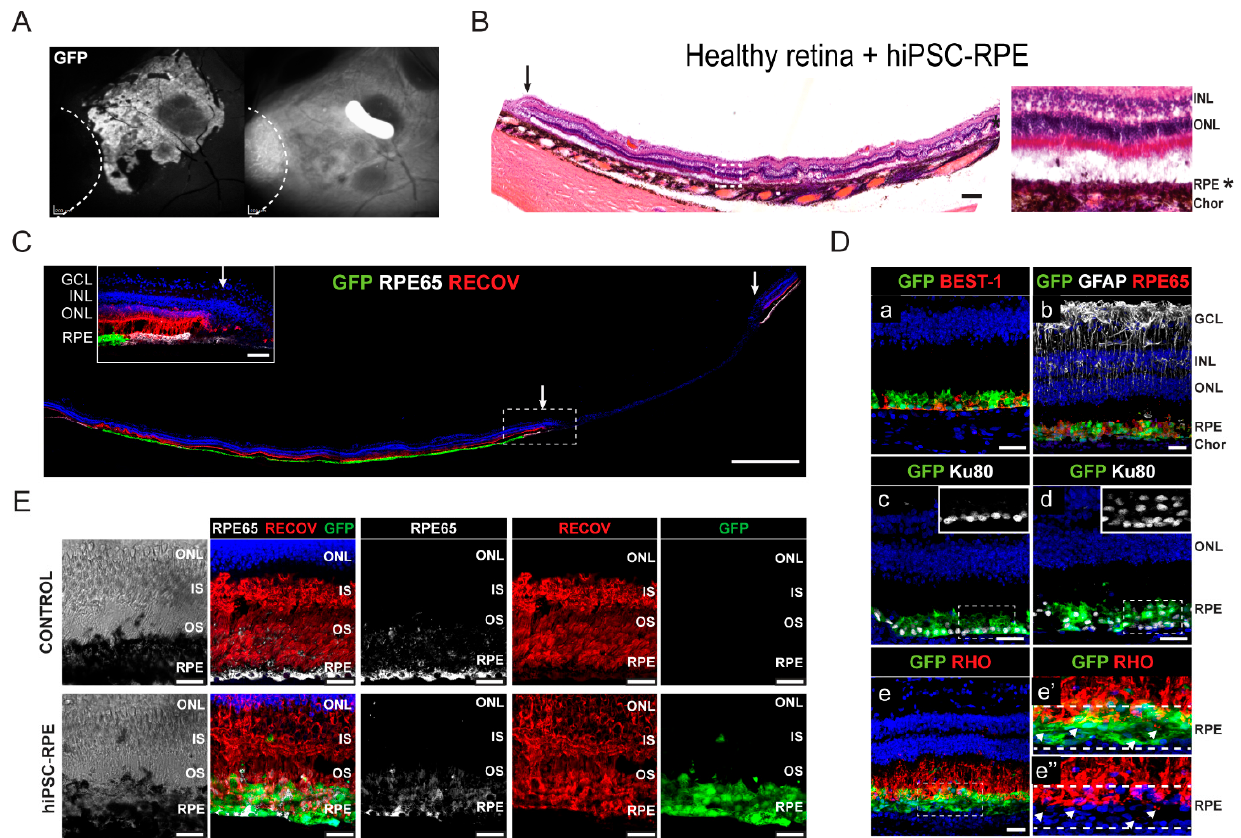
Figure 6. Analysis of engrafted hiPSC-RPE cells in healthy porcine retinas at three months post-transplantation in pigs 6 and 9. ( A ) Post-fixed FAF and IR of transplanted hiPSC-RPE cells in healthy retinas near the atrophy border. Atrophy is marked with a dashed line. ( B ) Compositions of hematoxylin and eosin (H&E) staining showing transplanted hiPSC-RPE cells (asterisk) in healthy retina. Arrow indicates the atrophy border. Scale bar: 400 μ m. White dashed square indicates a higher magnification image (right panel) showing the transplanted hiPSC-RPE cell layer (asterisk). Note that green fluo- rescence could not be seen after H&E staining. ( C ) Confocal composition of integrated hiPSC-RPE cell layer in the healthy retina extending towards the transition zone of the atrophic area in pig 9 immunolabeled with RPE65 and recoverin (RE- COV). Scale bars: 1000 μ m. Inset shows magnification of the margin of the atrophy indicated by a dashed square. Arrows indicate atrophy border. Scale bars: 50 μ m. ( D ) Immunohistochemical staining of engrafted hiPSC-RPE cells in healthy retina showing the expression of RPE-specific markers bestrophin-1 (BEST-1) and RPE65 (a,b). Retinal glia was stained with GFAP. The human nuclear antigen Ku80 was used to detect human cells corresponding to transplanted hiPSC-RPE cells (c,d, insets show magnification of Ku80+ nuclei). Photoreceptor cells were detected by rhodopsin (RHO) marker (e). Enlargement RHO (e’,e’’) immunofluorescence images showing contact between hiPSC-RPE cells and photoreceptor outer segments revealing numerous immunolabeled phagosomes (white arrowheads). Dashed lines indicate the GFP+ hiPSC- RPE layer. Scale bars: 25 μ m. ( E ) Bright-field images of control and transplanted retinas (left panels). Immunohistochem- ical staining of control retina and transplanted retina with engrafted hiPSC-RPE cells showing the expression of RPE- specific marker RPE65 and photoreceptor marker recoverin (RECOV) (right panels). Scale bars: 25 μ m. Cell nuclei were stained with DAPI (blue). FAF, fundus autofluorescence; IR, infrared image; RPE, retinal pigment epithelium; ONL, outer nuclear layer; INL, inner nuclear layer; GCL, ganglion cell layer; Chor, choroid; GFP, green fluorescent protein.